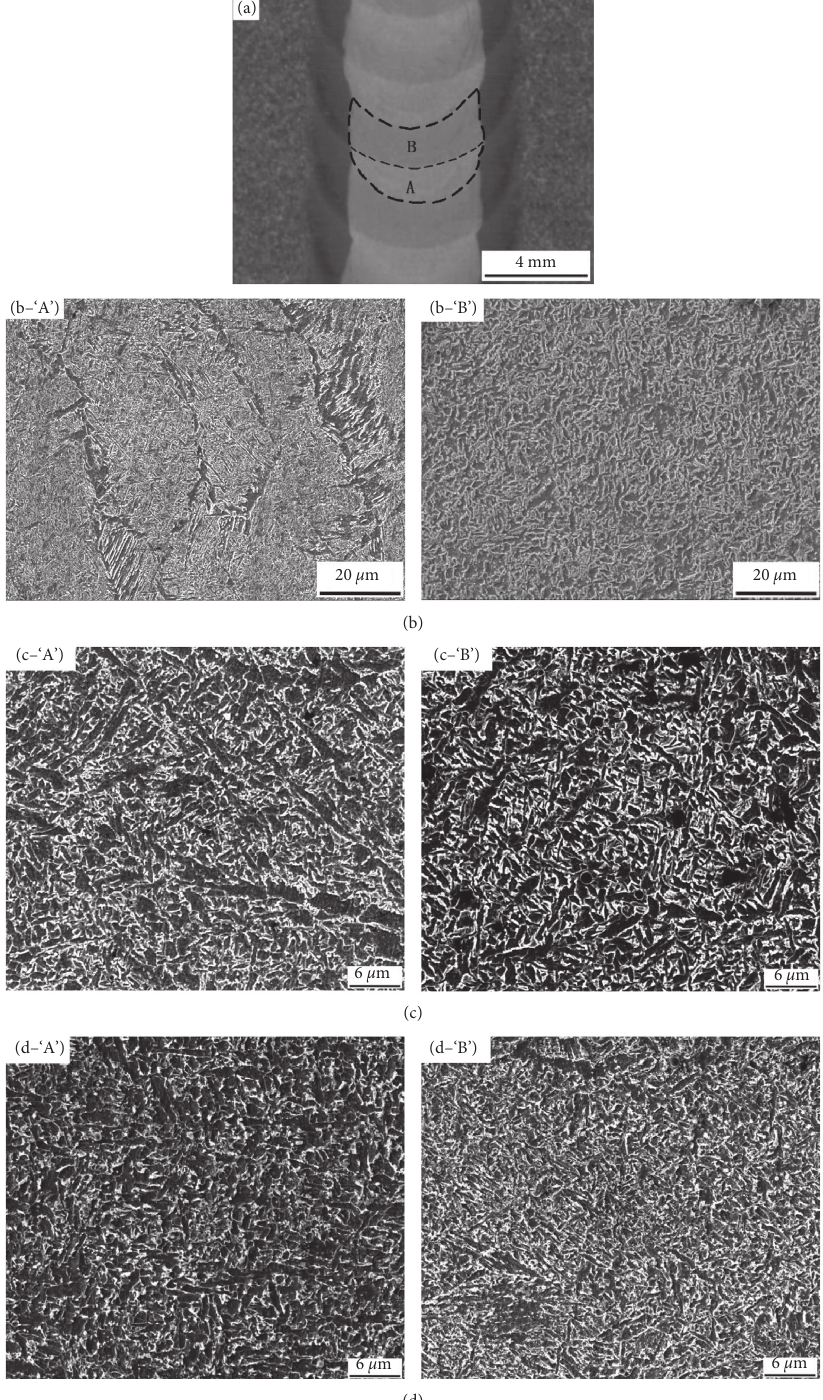
Figure 5: The microstructure of weld metal: (a) macroscopic picture of weld metal, (b) 0% alloying element, (c) 9% alloying element, and (d) 19% alloying